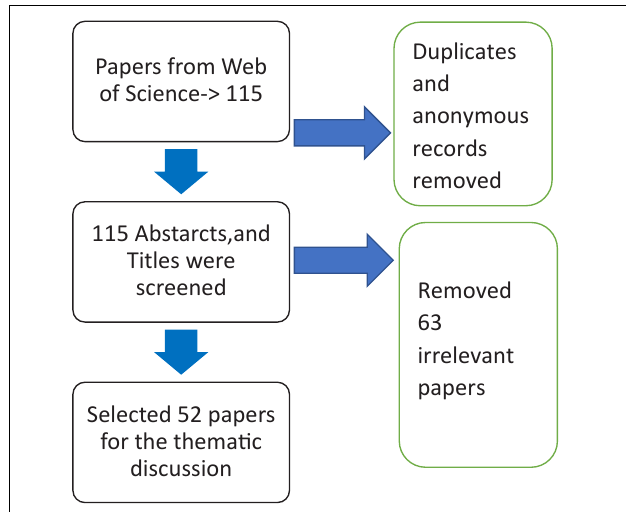
FIGURE 1 | Paper identification and screening